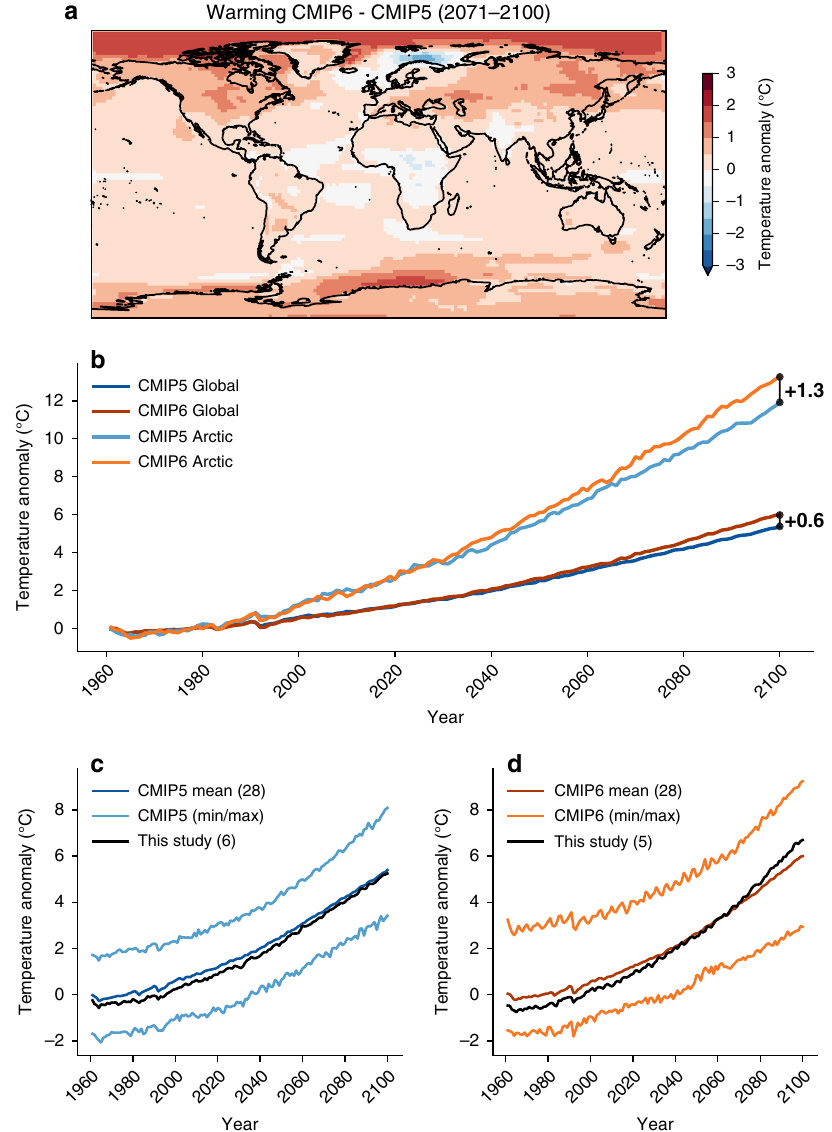
Fig. 1 Temperature comparison between CMIP5 and CMIP6 models. a Difference in warming (CMIP6 mean minus CMIP5 mean) at the end of the twenty- fi rst century (2071 – 2100 30-year average) when compared to the baseline of 1961 – 1990. Red colors suggest a greater warming in CMIP6. The difference is computed from all available CMIP5 (28) and CMIP6 models (28) from the RCP8.5 and the SSP58.5 scenarios, respectively. b Time series of the CMIP5 and CMIP6 global and Arctic near-surface temperature anomaly between 1960 and 2100 (mean of all GCM models), compared to the 1961 – 1990 baseline. c Comparison between the 28 model CMIP5 global mean temperature anomaly (dark blue, reference period 1961 – 1990) and the mean of the 6 GCMs chosen for our dynamical downscaling (black), and the minimum and maximum of all CMIP5 GCMs (pale blue). d Same as c but for 28 CMIP6 GCMs and the mean of the 5 GCMs chosen for our downscaling in this